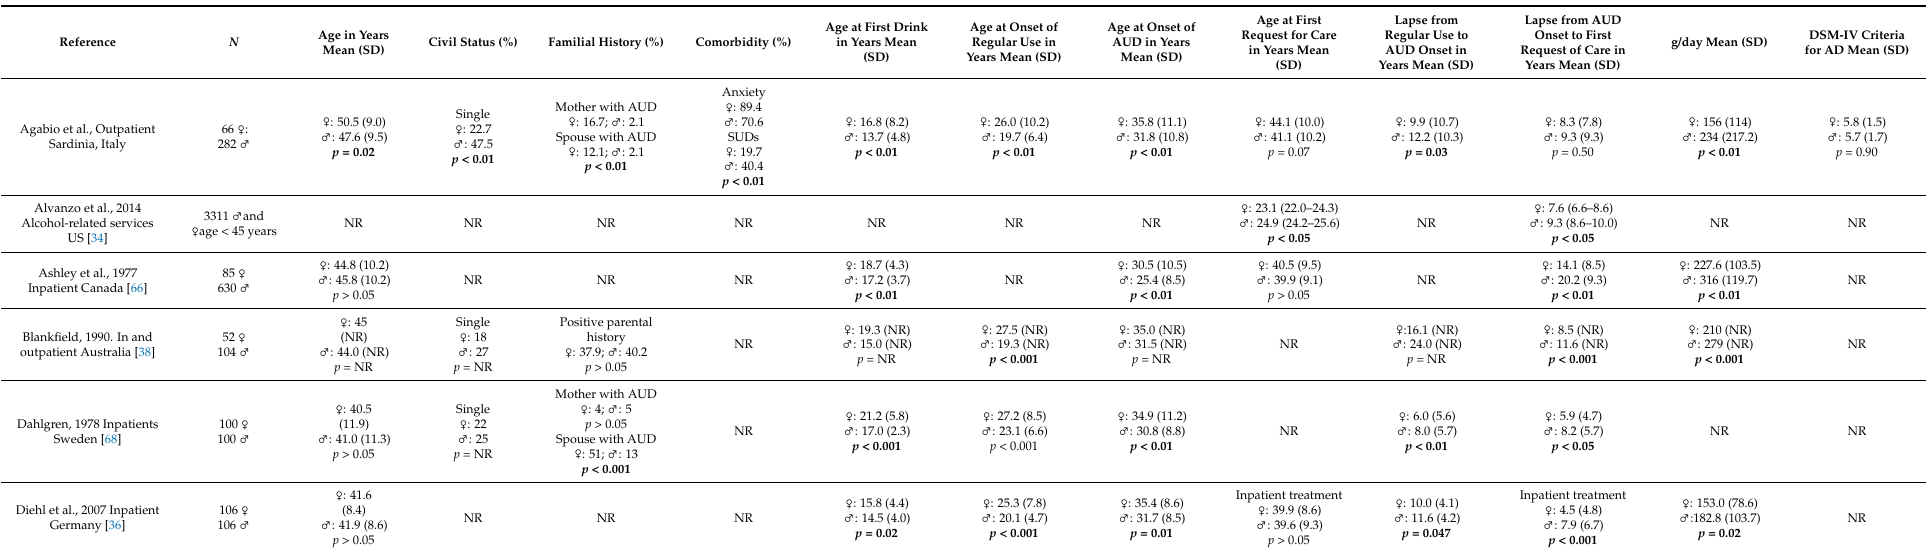
Table 3. Gender differences in drinking characteristics of AUD Sardinian patients compared with those of AUD patients living in other